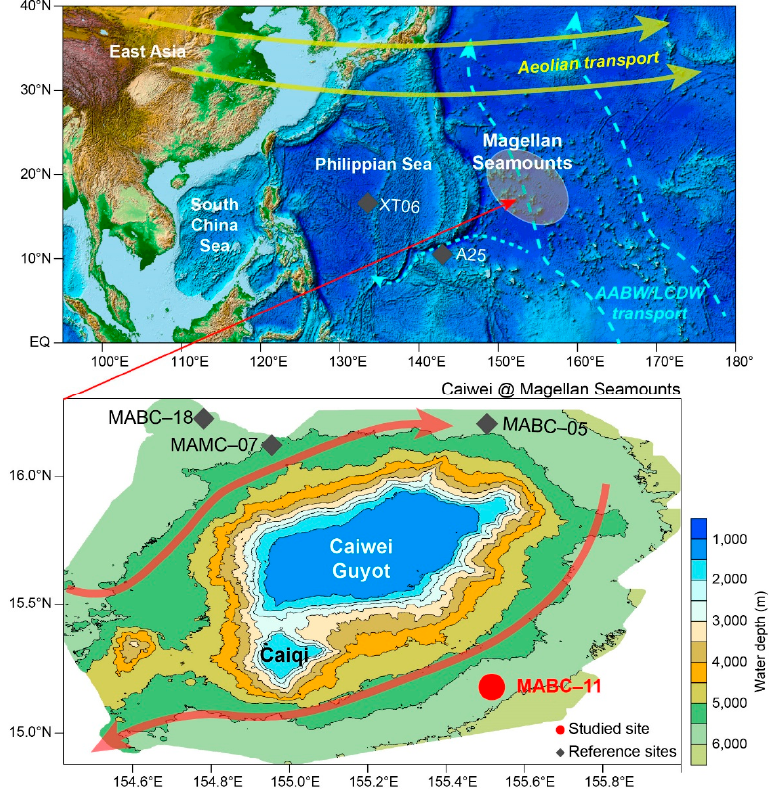
Figure 1. Schematic map showing the study area and oceanographic setting. The flow passing through the seamount and a Taylor column was observed based on the data obtained by the con- ductivity temperature and depth instrument (CTD) and mooring system [23,24]. Three sites were referenced in the study: site MAMC–07 (154.92 ◦ E, 16.08 ◦ N, 5,778 m water depth; 0.50 mm/kyr), and MABC–18 (154.79 ◦ E, 16.22 ◦ N, 5,644 m; 0.55 mm/kyr) [19], and site MABC–05 (155.40 ◦ E, 16.17 ◦ N, 5,840 m) [25]. All the flows were modified from previous studies [21,24,26]. The base map data was generated using the open and free software DIVA–GIS 7.5